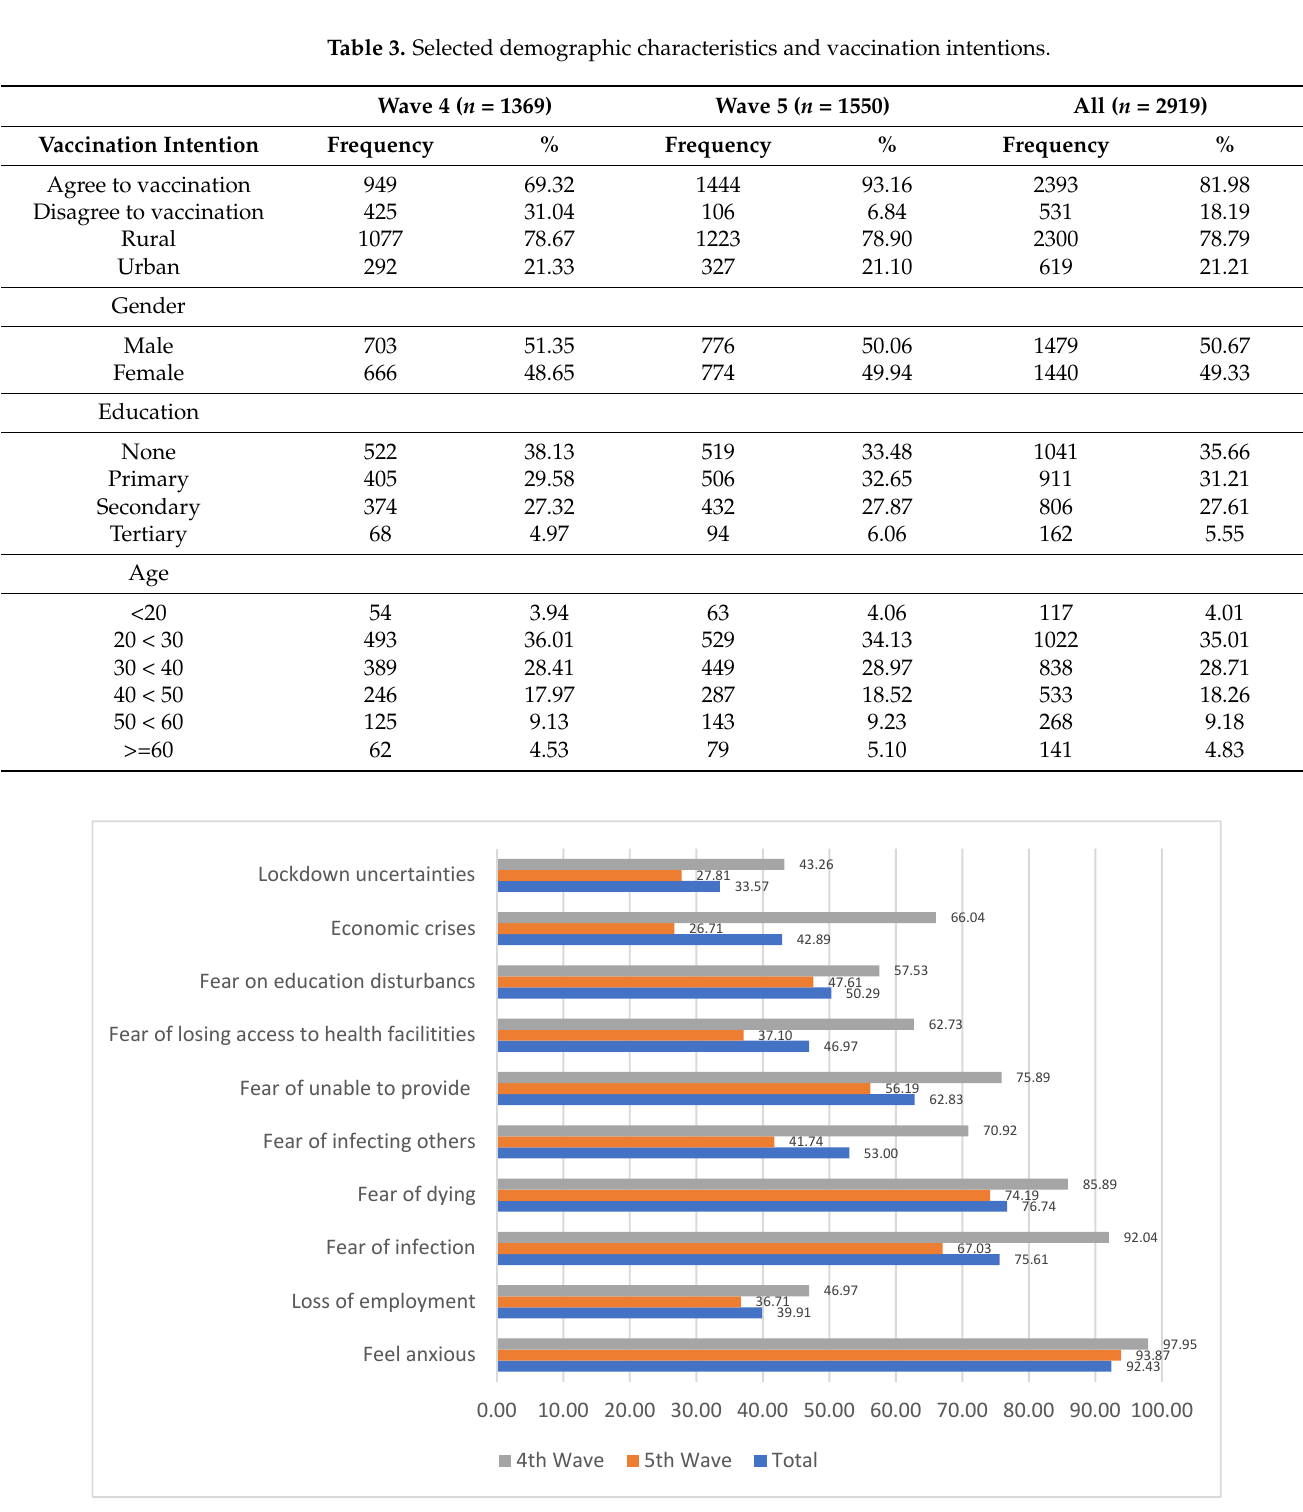
Figure 2. Different forms of anxiety experienced.